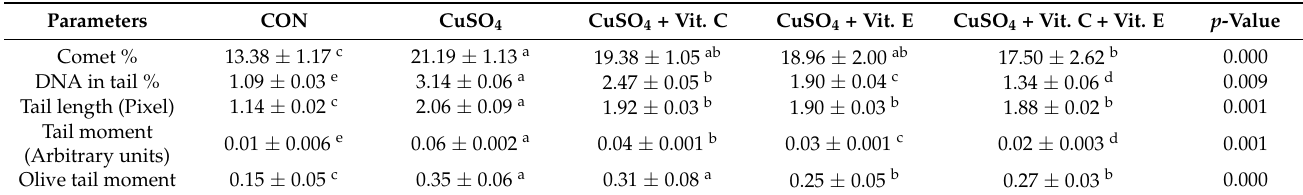
Figure 1. Electrophoresis of hepatic DNA samples of chicken from all experimental groups, using 1.2% ethidium bromide- stained agarose (×400). ( a ) : The control group showed no DNA damage, as demonstrated by the lack of DNA fragment migration away from the nucleus core. ( b , c ): CuSO4 group showed a high degree of DNA damage, with a significantly reduced nucleus core and a large cloud of DNA fragments migrating away from the core, forming the characteristic comet tail. ( d ): CuSO 4 + Vit. C group showed a moderate degree of DNA damage. ( e ): CuSO 4 + Vit. E group showed a reasonable degree of DNA damage. ( f ): CuSO 4 + Vit C + Vit E group showed a minimal degree of DNA damage. Table 7. Effect of single or combined supplementation of vitamin C and E on the DNA degradation indices in broiler chickens at the end of the 3rd week (Mean ±